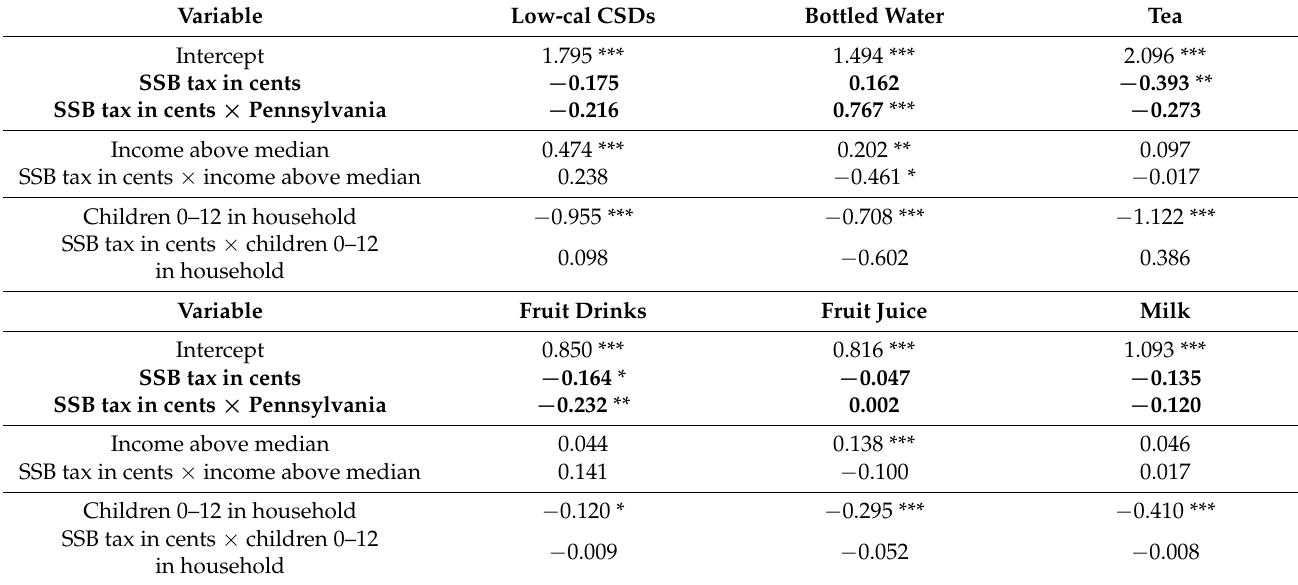
Table 3. Multivariate Models of Other Beverages Purchased by Study